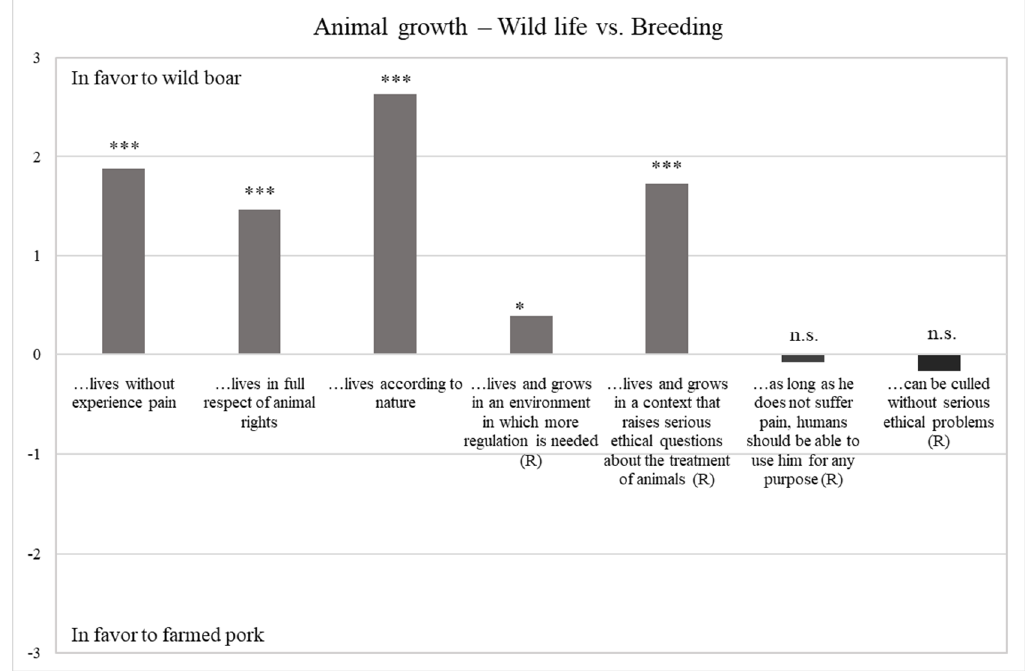
Figure 1. Difference between perceptions towards wild life vs. Breeding. *** Sign. < 0.001; ** Sign. < 0.010; * Sign.< 0.050; n.s. not significant.